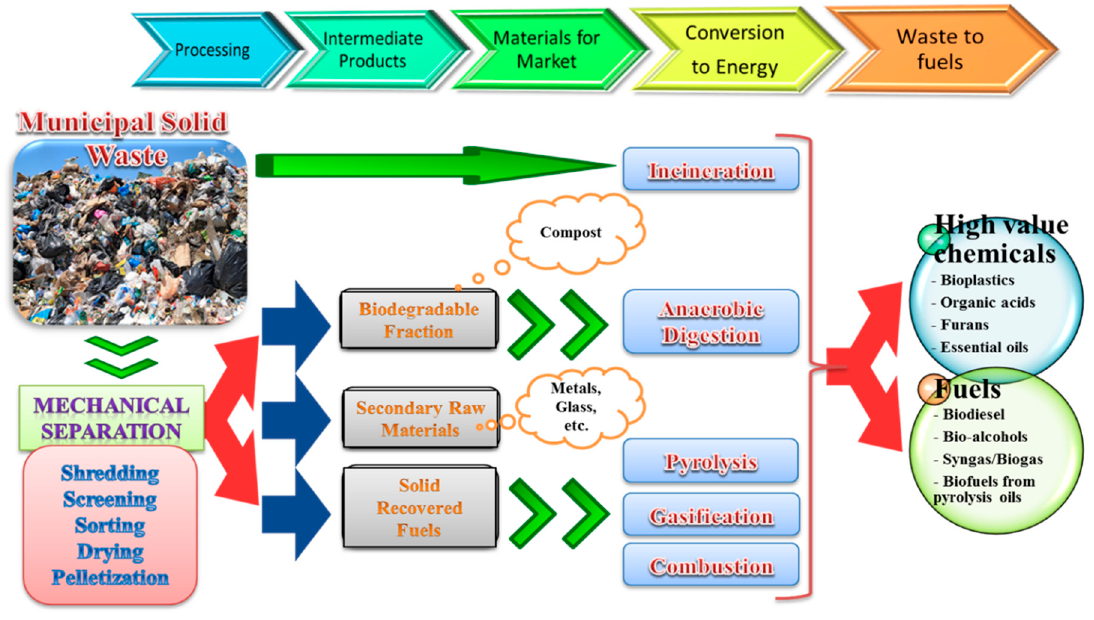
Figure 2. Processing of MSW.